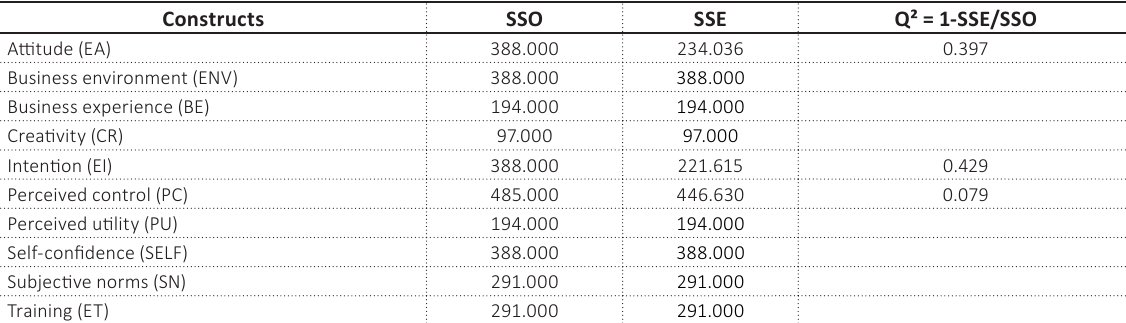
Table A3. Construct cross-validated redundancy (Q 2 )